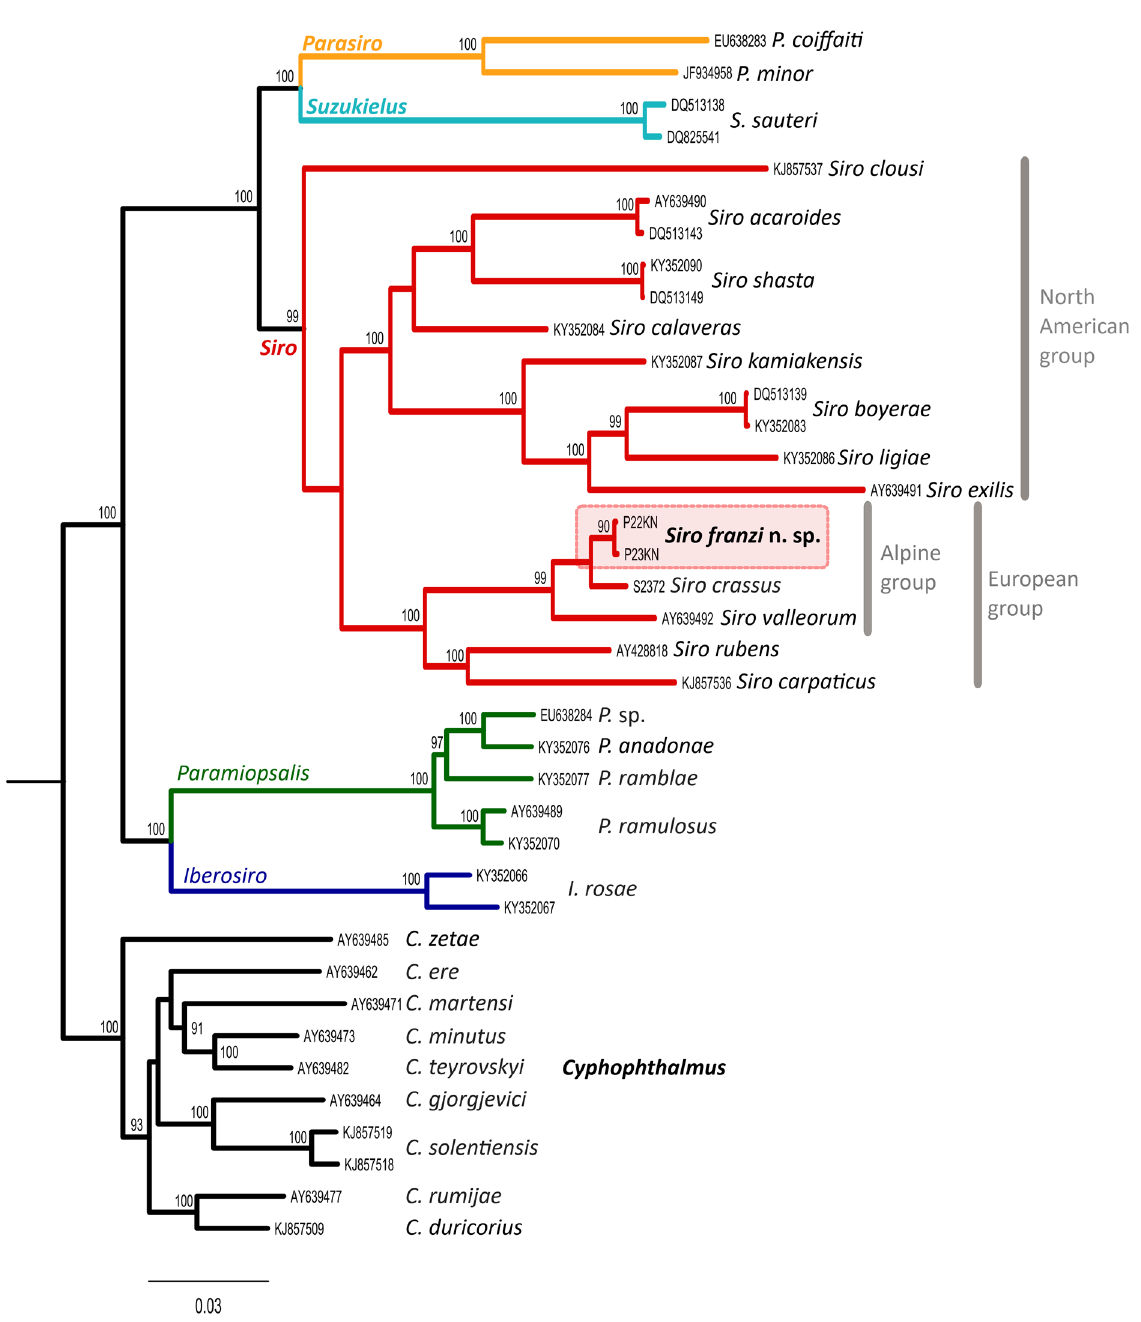
Fig. 2. Bayesian inference topology of the combined dataset (18S, 28S, 16S, COI; 4936 bp) of Sironidae Simon, 1879 comprised of 38 taxa. Posterior probabilities > 90 are shown close to nodes. Coloured branches refer to different